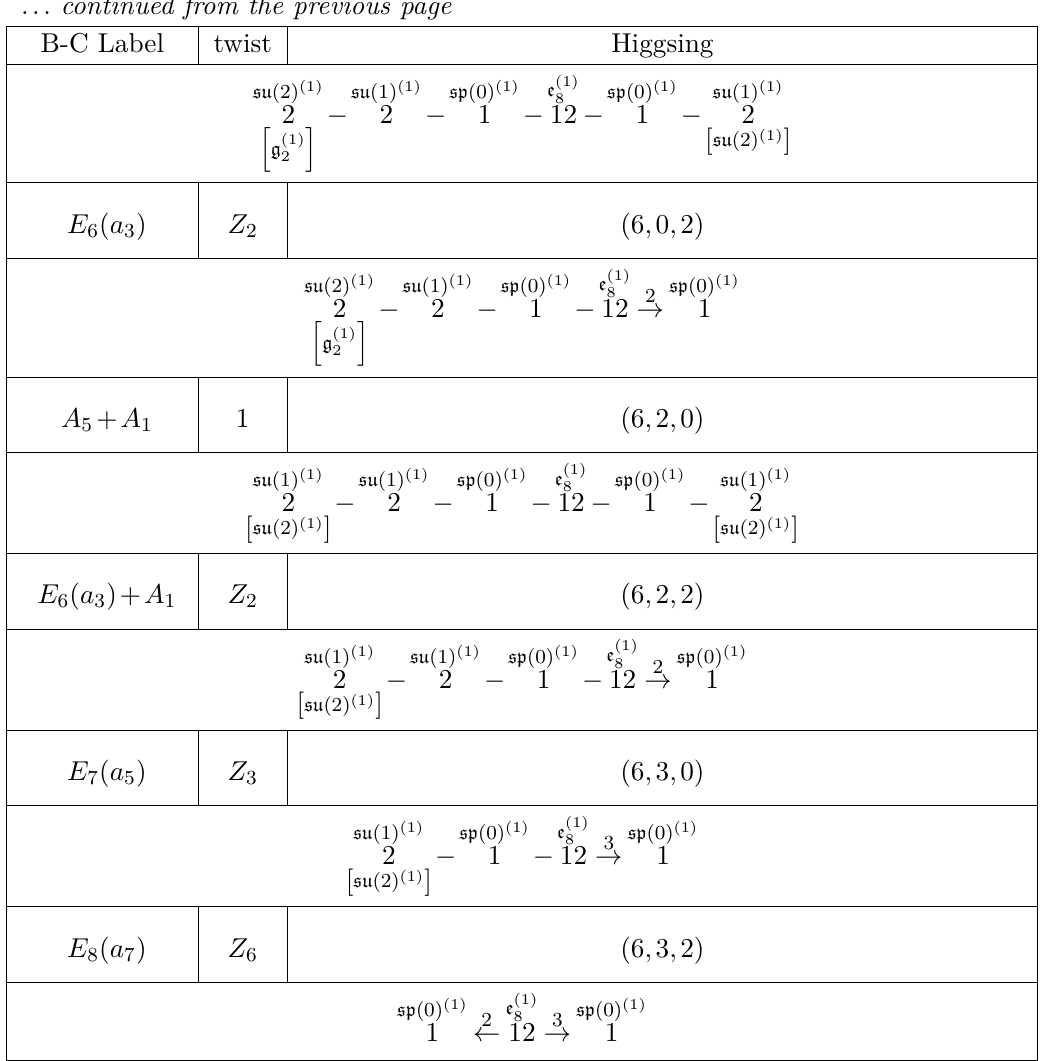
Table 7. Higgsings labeled by ( a 1 ,a 2 ,a 3 ) for the theory